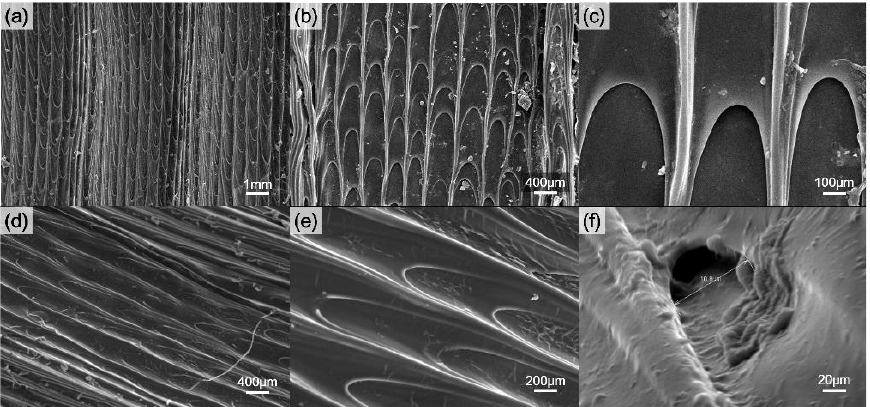
Figure 6. SEM images of ( a – c ) the real (pristine) Nepenthes peristome and ( d – f ) the replica of the Nepenthes peristome-like structure of PDMS.